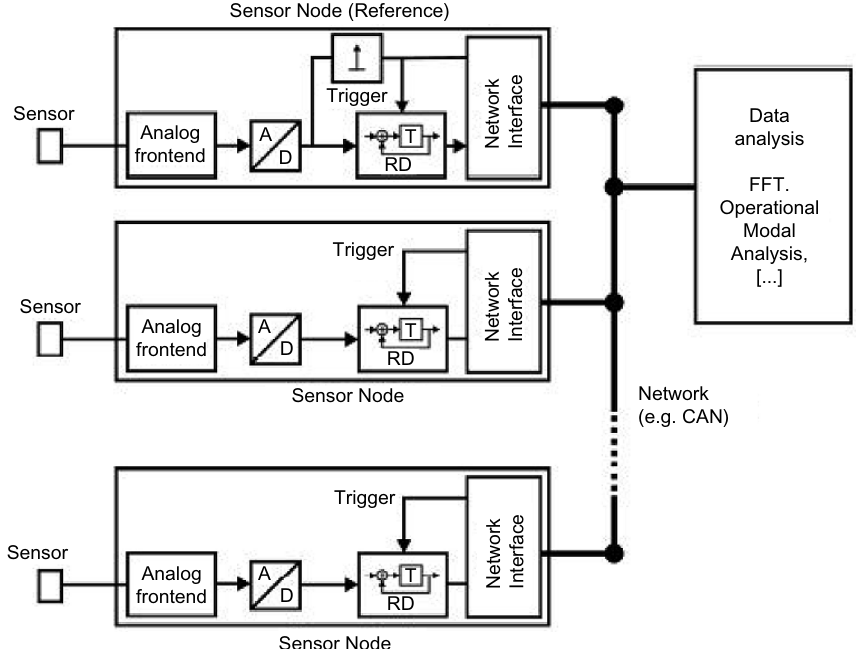
Fig. 3. System layout for decentralized RD estimation and subsequent data